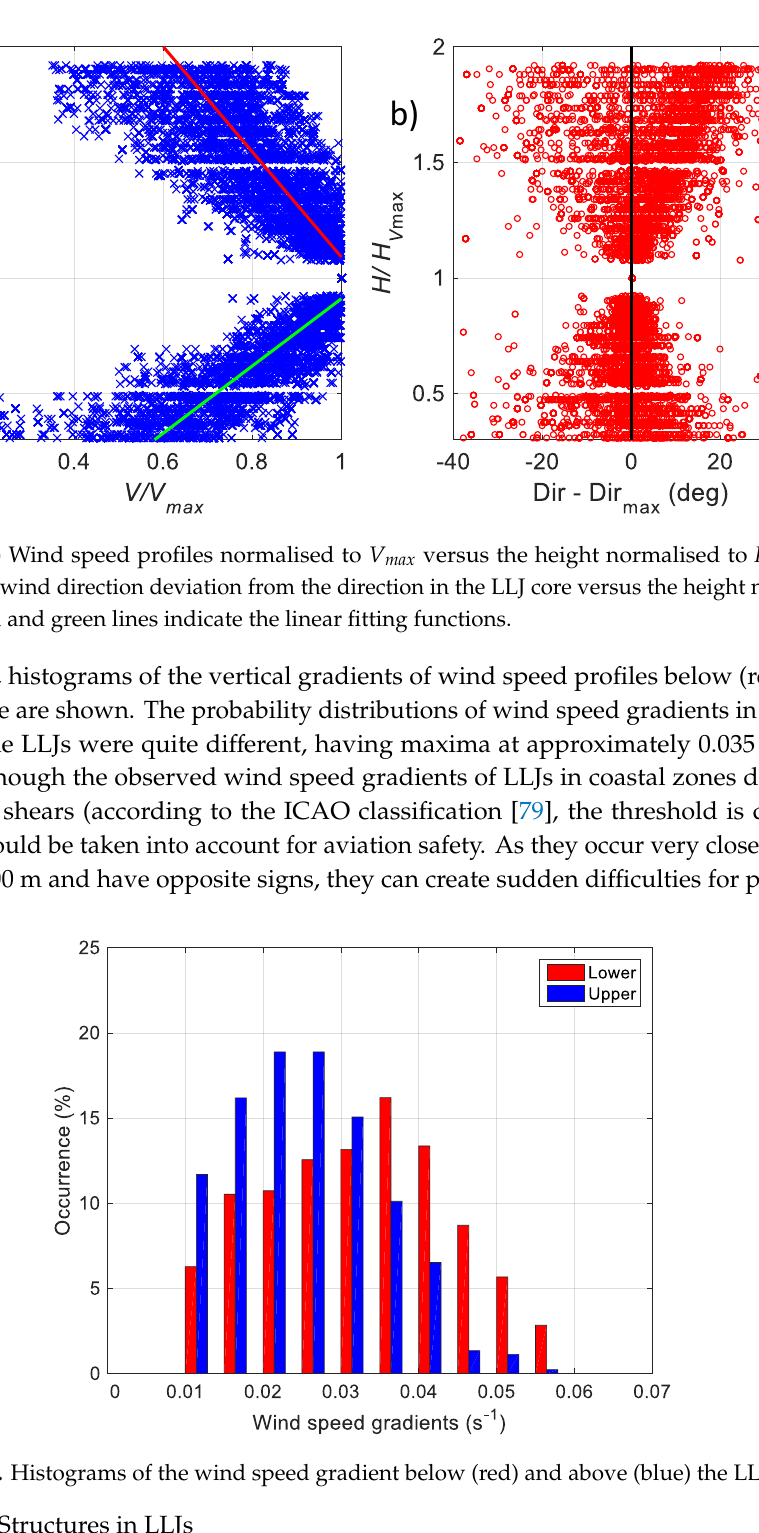
Figure 30. Histograms of the wind speed gradient below (red) and above (blue) the LLJ core.